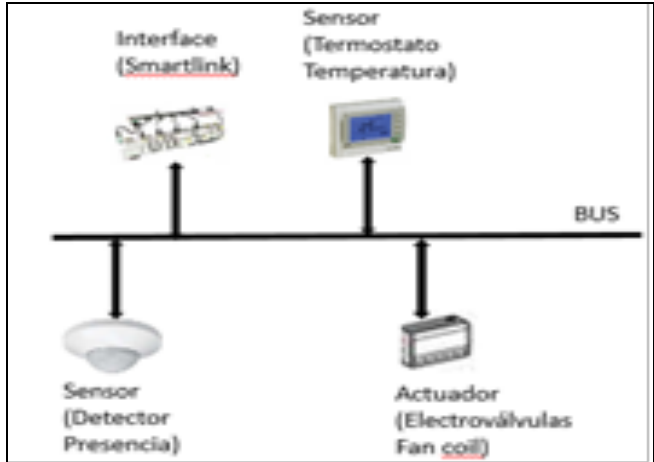
Figura 6: Elementos de campo. Fuente: Los autores,